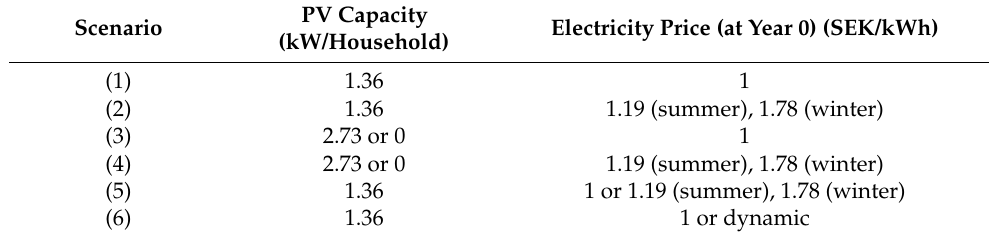
Table 1. PV capacities per household and prices in the 6 different